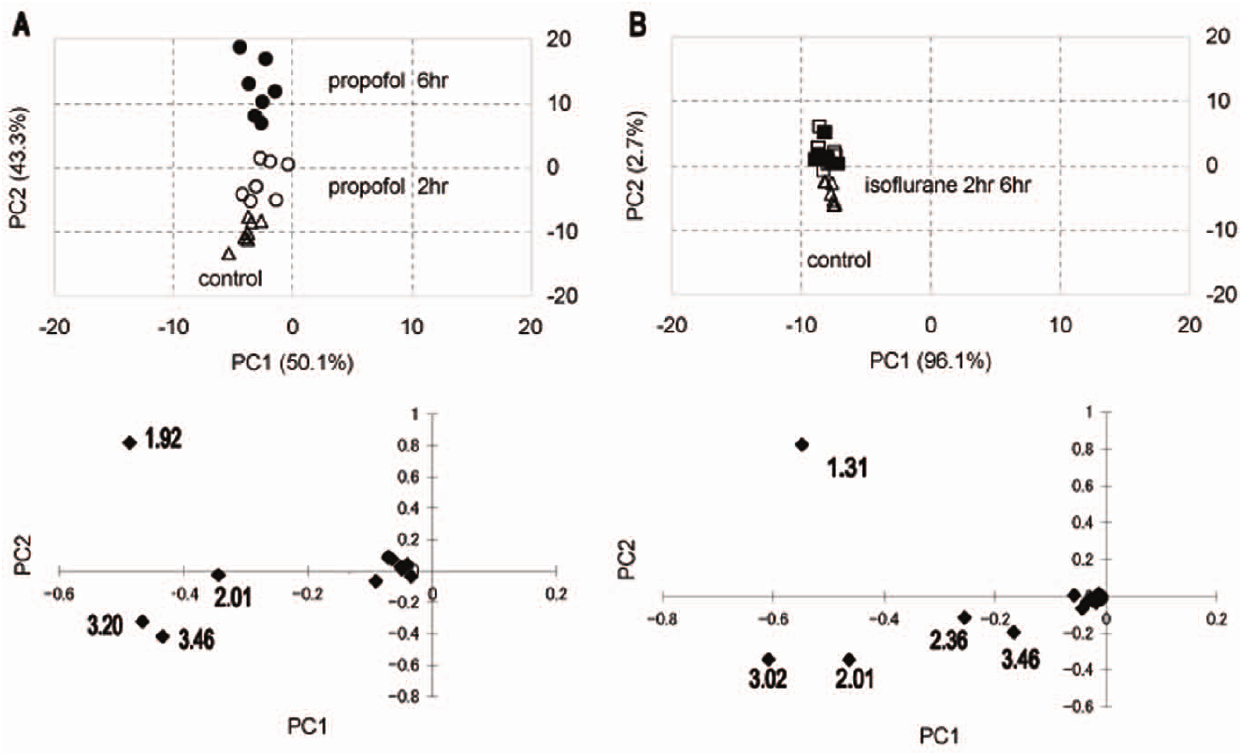
N Figure 4. PCA score plot of hydrophilic brain extracts. Each mark represents the metabolic data set from an individual rat. (A) Control ( n ), ). (B) Control ( n ), isoflurane 2 h ( % ) and isoflurane 6 h ( & ). Variables (n=1\educed from 177). The lower graphs propofol 2 h ( # ), and propofol 6 h ( are PC loading plots of individual data sets to distinguish single putative NMR peaks responsible for the clustering pattern observed in the PCA score plot.